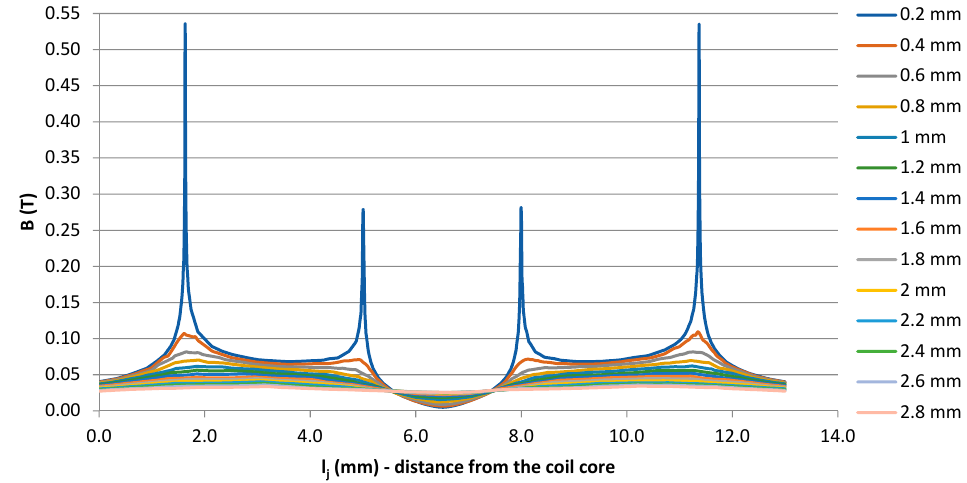
Figure 14. Magnetic induction distribution along the inner diameter of the air gap of the inductor described by situation Figure 12a.